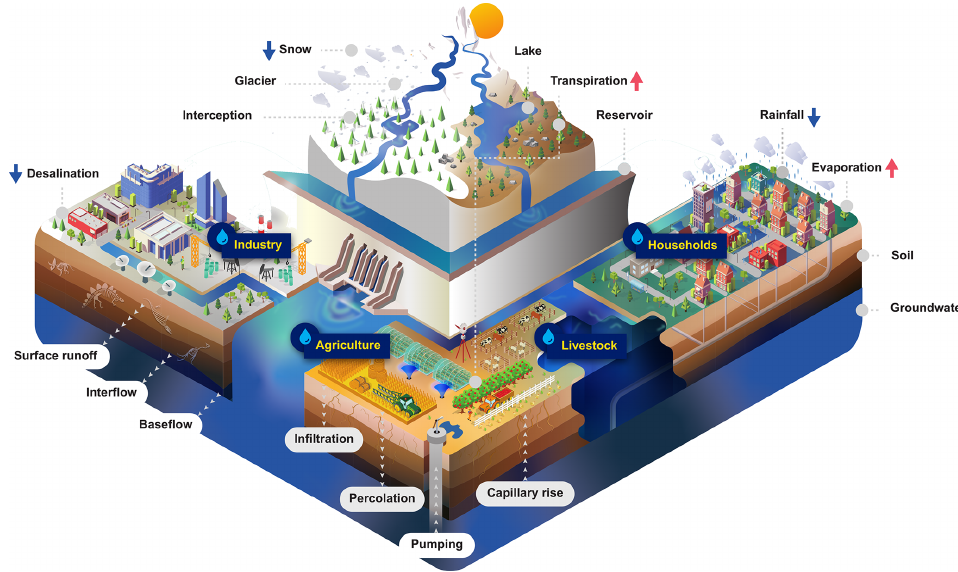
Figure 1. Schematic figure of the processes included in the